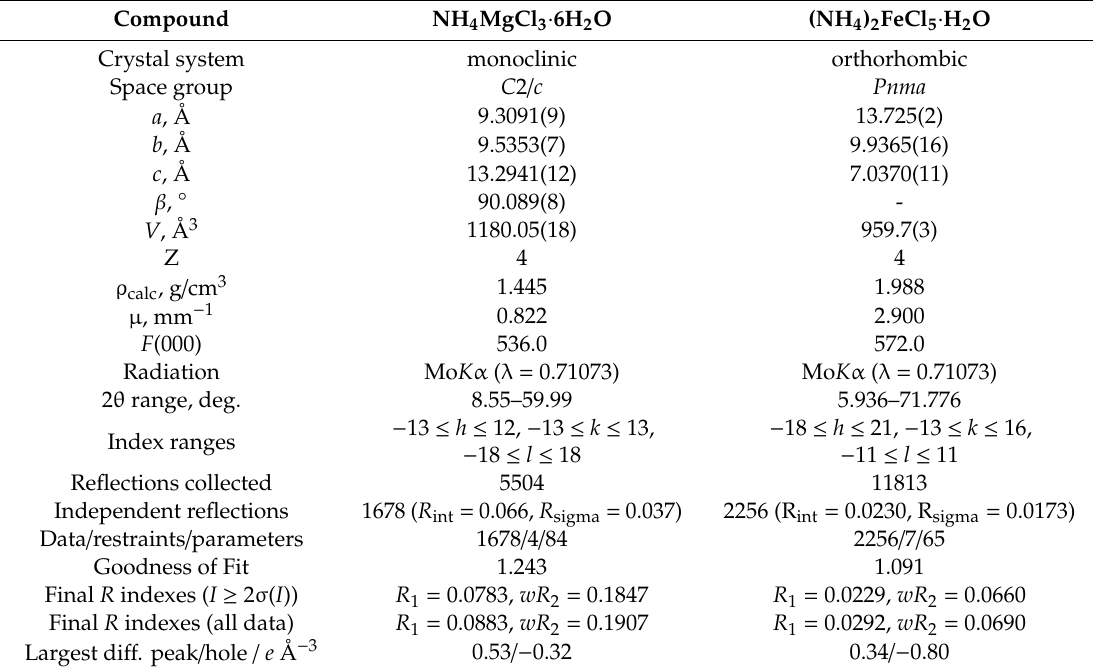
Table 4. Crystal data and structure refinement for NH 4 MgCl 3 · 6H 2 O and (NH 4 ) 2 Fe 3 + Cl 5 · (H 2 O).